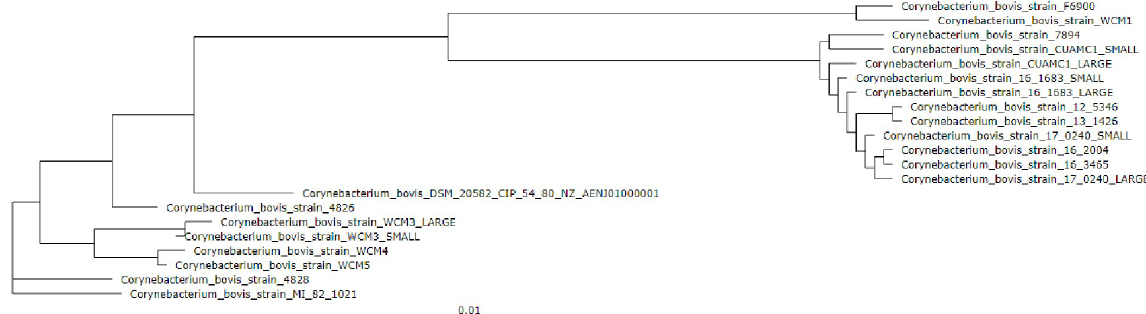
Fig 3. Phylogenetic tree for 21 C . bovis genomes. The tree was built of a core of 1,354 genes per genome, 28,434 in total. The core has 598,172 amino acid-residues/bp per genome, 12,519,612 in total. Tree